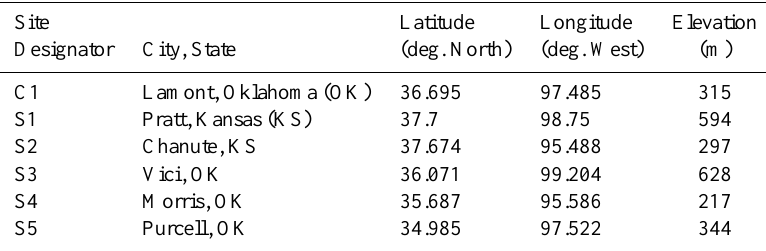
Table 1. Summary of MC3E sounding array